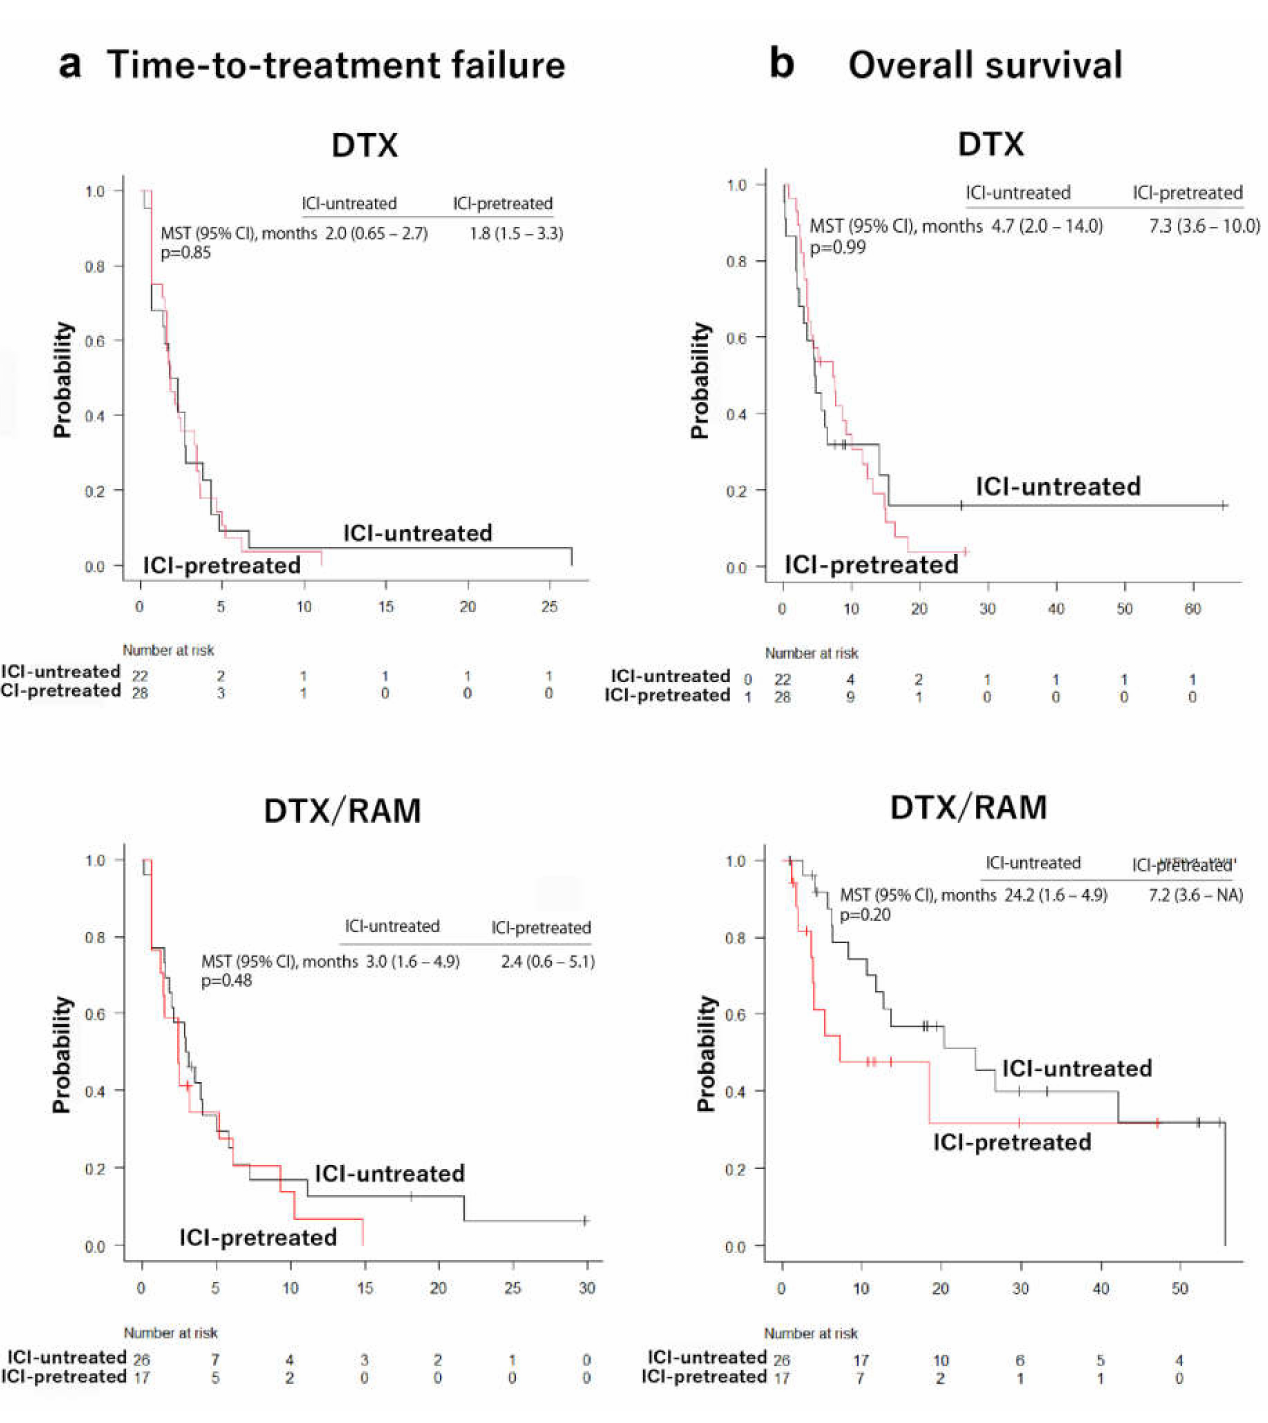
Figure 4. Comparative analysis of immune checkpoint inhibitor-pretreated and -untreated patients in each docetaxel-treated and docetaxel/ramucirumab-treated group. The time-to-treatment failure and overall survival were not significantly different between checkpoint inhibitor-pretreated and –untreated patients in each docetaxel (DTX)-treated and docetaxel/ramucirumab (DTX/RAM)-treated